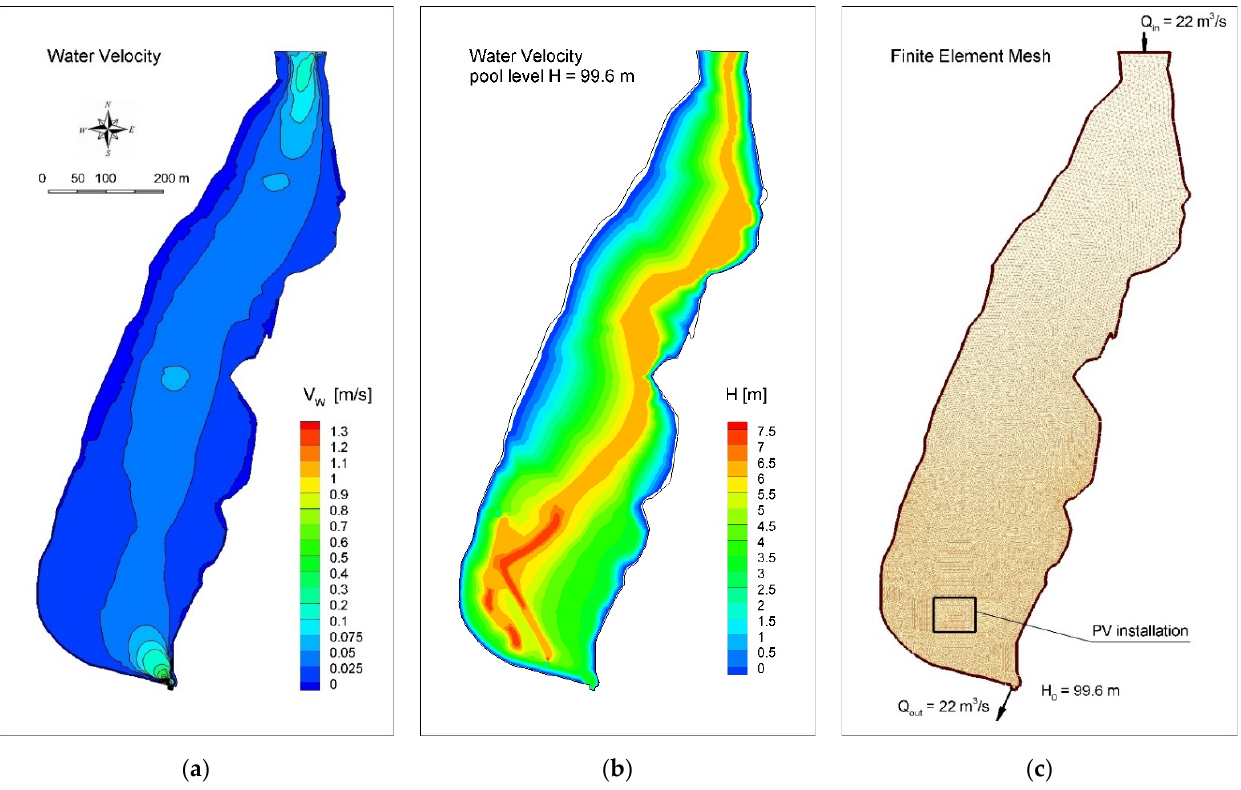
Figure 5. Results of numerical simulations conducted on the Łapino reservoir, Q = 22 m 3 /s and the pool level H 0 = 99.6 m Figure 5 Results of numerical simulations conducted on the Ł apino reservoir, Q = 22 m 3 /s and the pool level H 0 = 99.6 m ( a ) water ( a ) water velocity, ( b ) water depth ( c ) finite element mesh for the area from the Łapino reservoir; the figure shows the velocity, ( b ) water depth ( c ) finite element mesh for the area from the Ł apino reservoir; the figure shows the locations of open boundary conditions-flow and water level. locations of open boundary conditions-flow and water